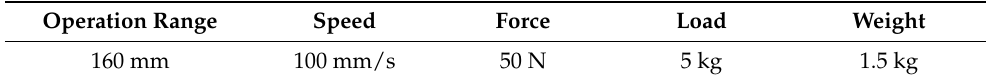
Table 2. Specifications of the